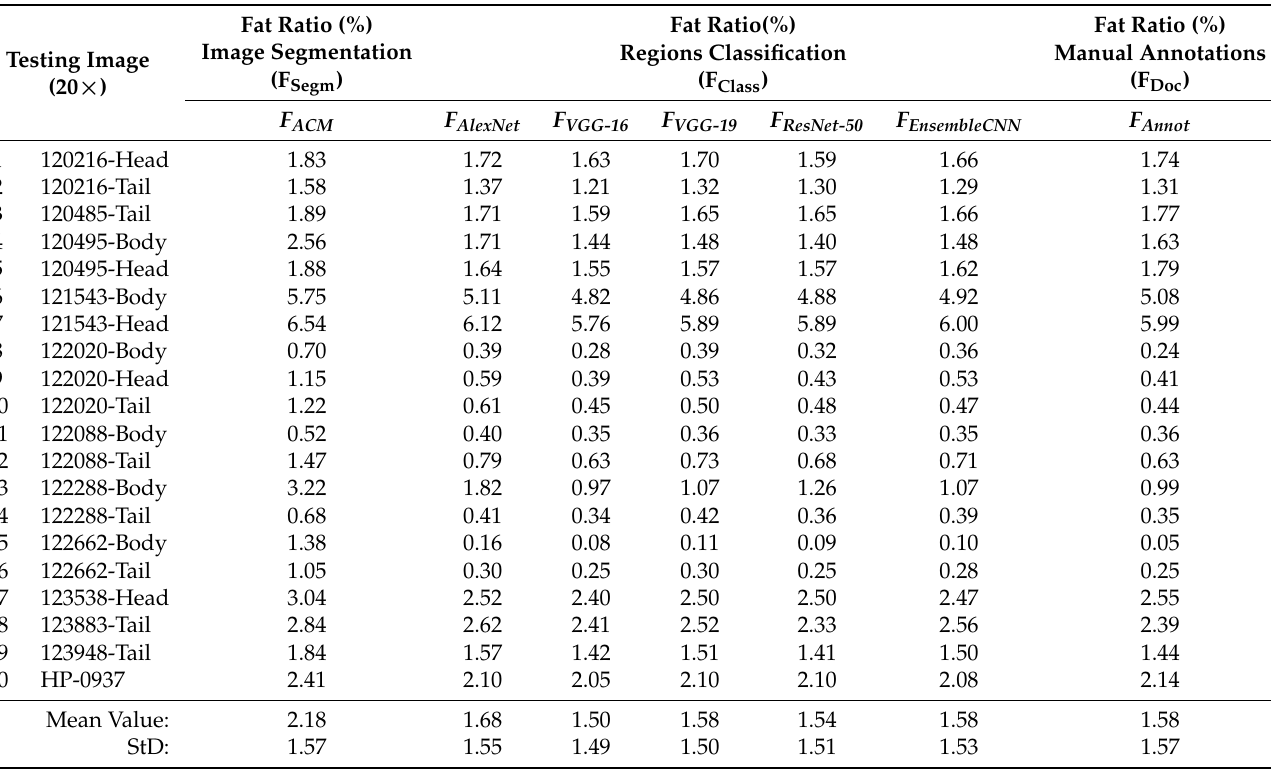
Table 4. Pancreatic fat quantification results.